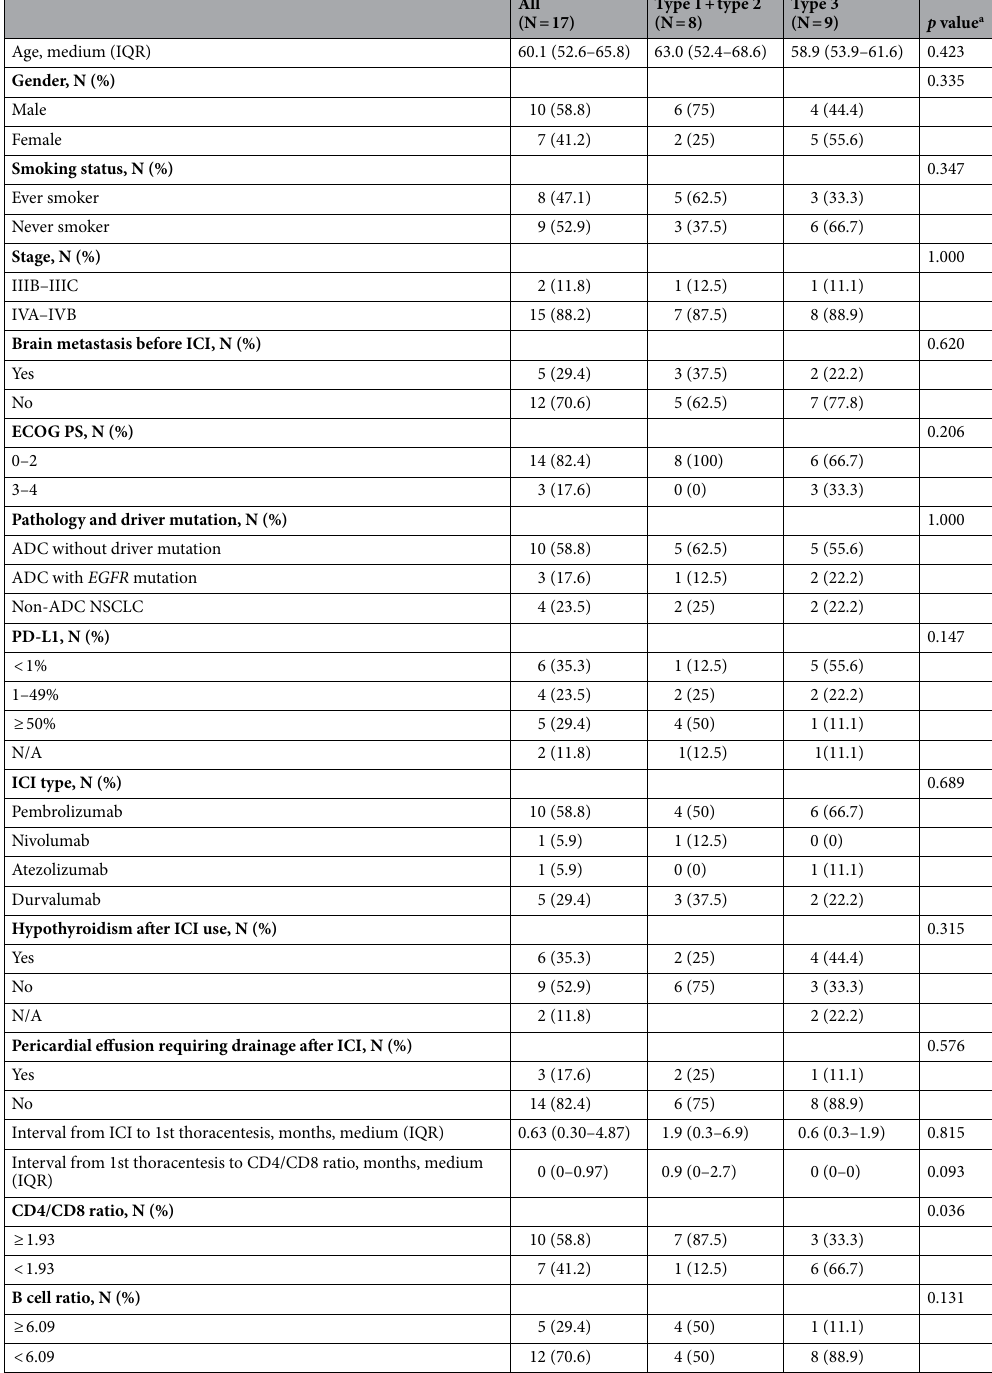
Table 1. Demographic data and characteristics of different pleural effusion types. ICI, immune checkpoint inhibitor; ECOG PS, Eastern Cooperative Oncology Group performance status; ADC, adenocarcinoma; NSCLC, non-small cell lung cancer; N/A, not applicable; PR, partial response; SD, stable disease; PD, disease progression. a Probability value by Mann–Whitney U test and Fisher’s exact